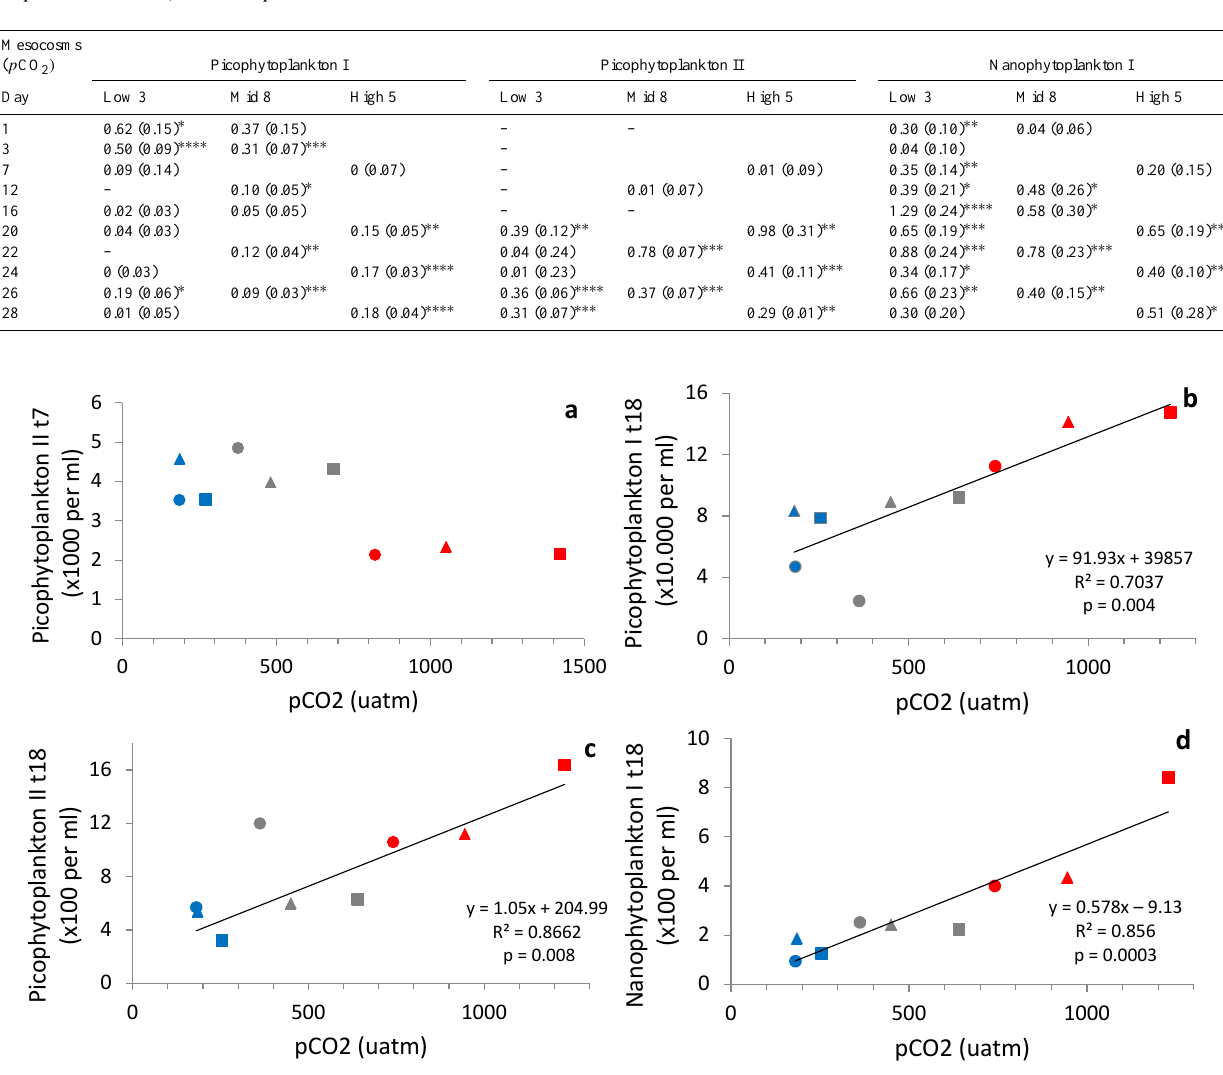
Table 1. Microzooplankton grazing rates on phytoplankton (d − 1 ) for 3 mesocosms representing low, intermediate (mid) and high p CO 2 lev- els. Mesocosm M3 (low, i.e. present time p CO 2 ) was sampled as reference to mesocosm M5 and M8. Failed assays for specific phytoplank- ton clusters are indicated by –. Standard error between parentheses. Statistical significance indicated by ∗ p = 0 . 1–0.05; ∗∗ p = 0 . 05–0.01; ∗∗∗ p = 0 . 01–0.001; and ∗∗∗∗ p = 0 . 001–0.